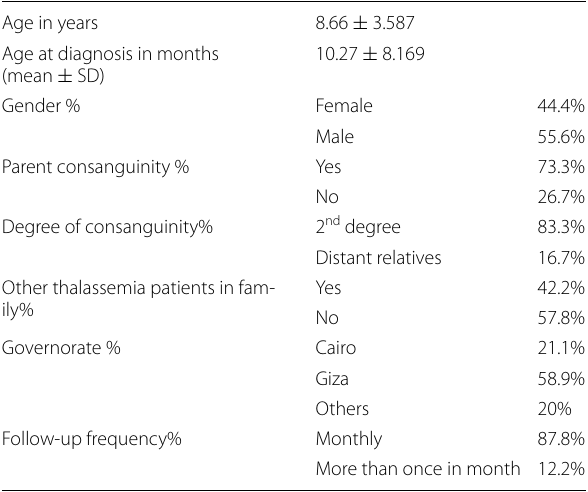
Table 1 Demographic data of the patients ( N